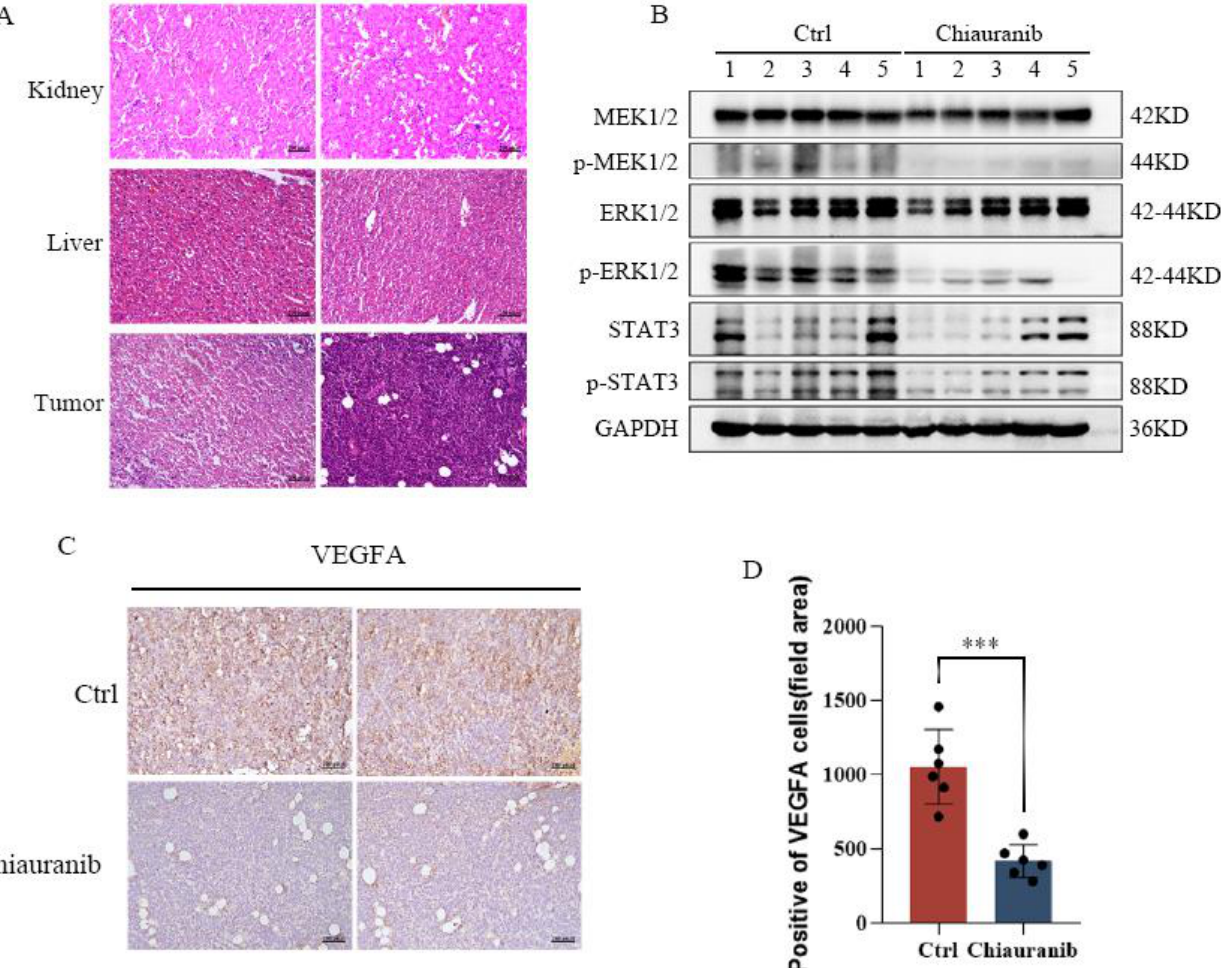
Figure 7. Chiauranib inhibits the MEK/ERK/STAT3 signaling pathway in vivo. ( A ) HE staining of the kidney, liver, and tumor (proportional scale 1:100 pixel). ( B ) Western blotting detection of the indicated protein extracted from tumor tissue (mice were orally administered 10 mg/kg/day chiauranib). ( C ) Immunohistochemistry assay of VEGFA in the chiauranib-treated (10 mg/kg/day) tumors compared with the control tumors (proportional scale 1:100 pixel). ( D ) Data from at least three independent experiments (*** p < 0.001).